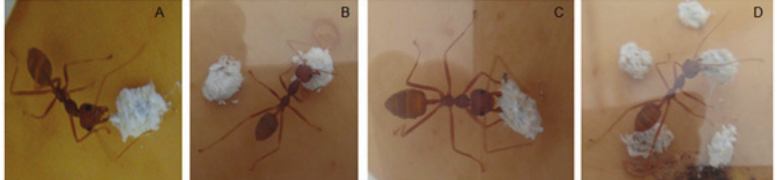
Figure 1. Oecophylla longinoda worker encounters with mummified mealybugs were always followed by an antennal examination ( A ) before transportation ( B – D ), indicating that they perceived the mummies as a potential food source.